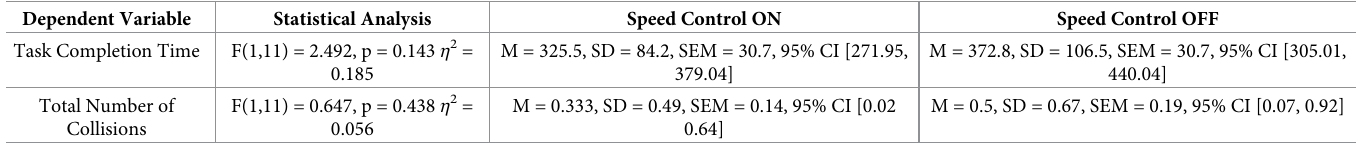
Table 3. Study 2 ANOVA results and statistical measures. Dependent Variable Statistical Analysis Speed Control ON Speed Control